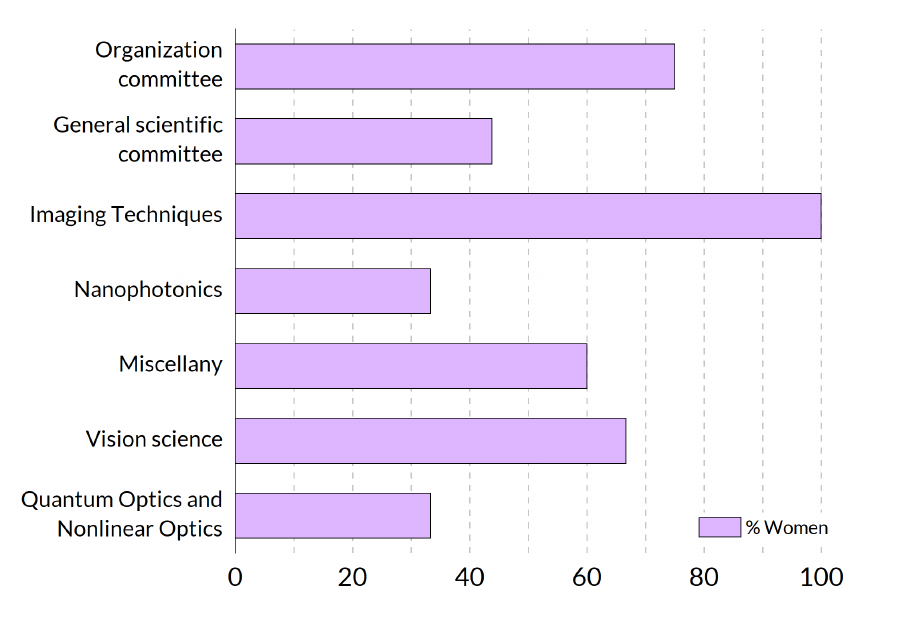
Figure 3. Percentage of women in the organization committee, general scientific committee and scientific committee of